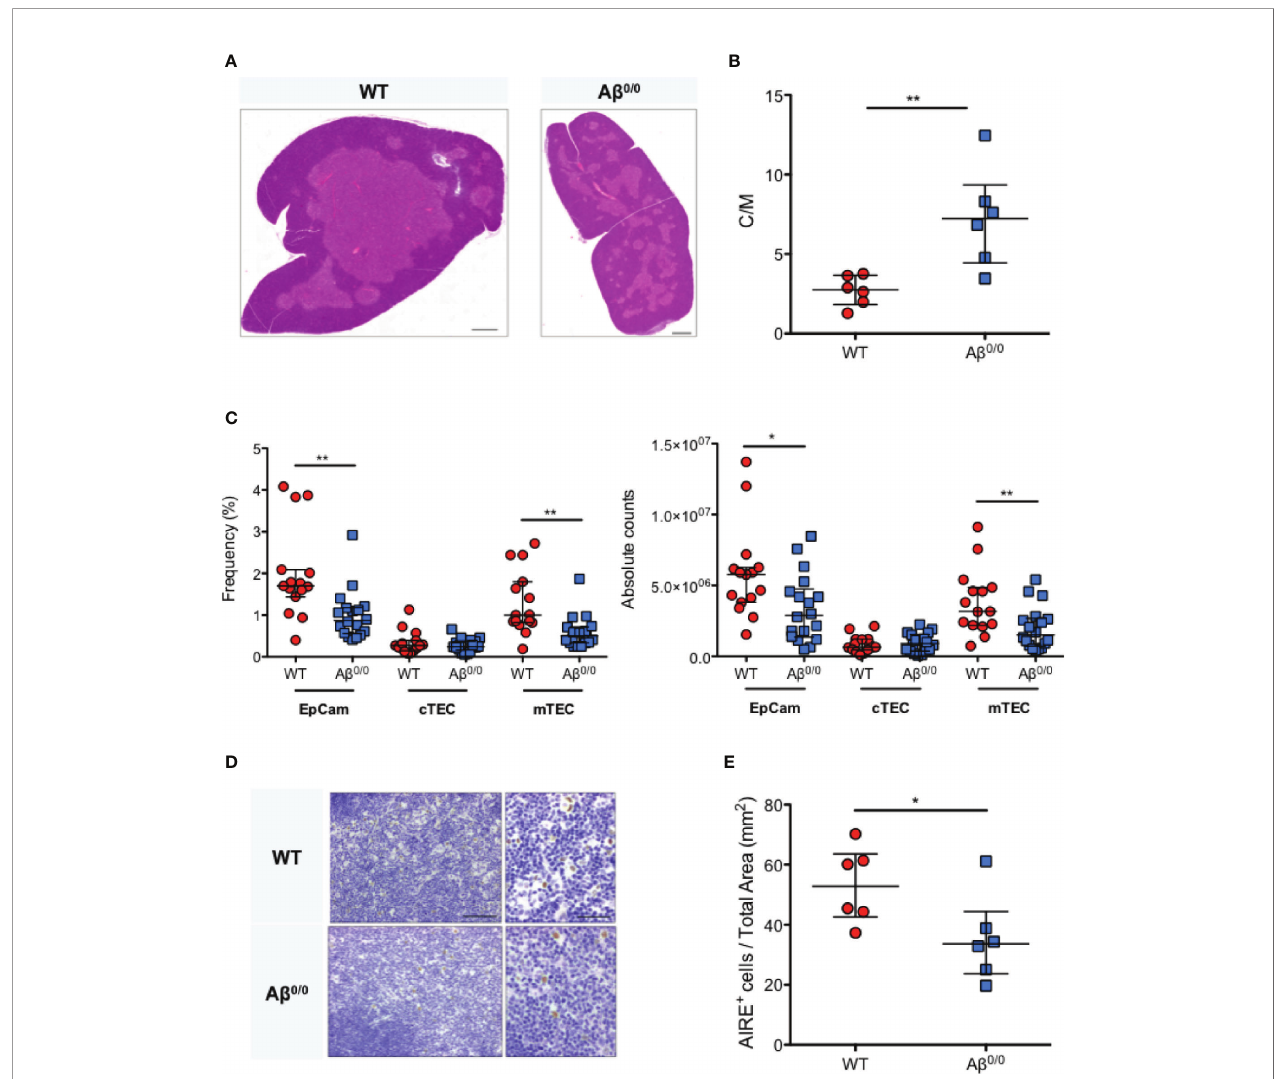
FIGURE 2 | Thymic structure perturbation in A b 0/0 mice thymus. (A) Reduced thymic medulla representation in A b 0/0 mice, con fi rmed by H&E staining as compared to WTmice. Scale barscorrespond to 500 m m. (B) Increasedcortico-medullary (C/M)ratio inA b 0/0 mice. Mann – Whitney test, **p-value<0.01. Median with interquartile range isshowed in thegraphfor each experimental group. (C) Reduced frequency ( leftpanel ) and absolute count( right panel ) ofTEC and mTEC in A b 0/0 mice after enzymatic digestion of thymic tissue anddepletion ofCD45 + cells. Mann – Whitney test, *p value < 0.05; **p value <0.01. (D) Immunohistochemical analysis of AIRE expression in WTandA b 0/0 mice thymi. Original magni fi cation: 20× for leftpanel and 40× for right panel for each condition,correspondingrespectively to 100 and 50 m m. (E) Frequency ofAIRE-expressing cells (AIRE + ) isreducedin A b 0/0 thymus. Comparisonofthe concentration of AIRE + cellsper mm 2 oftotal thymic tissue isolatedfrom WT or A b 0/0 mice. Mann – Whitney test, *p-value < 0.05. Median with interquartile range isshowed in the graph for each experimental